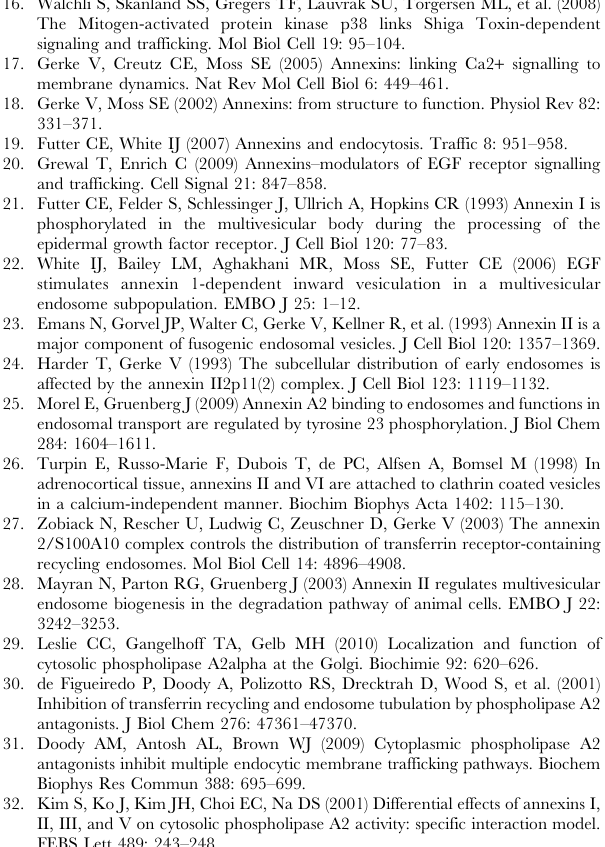
of total fluorescence for each marker, for one representative experiment (n= 3), where error bars indicate standard deviation. (TIF) Figure S5 Binding and endocytosis of Stx in Annexin A1 depleted cells. Stx binding and endocytosis following annexin A1 knockdown. HeLa cells transfected with siRNA as indicated for 72 h were incubated with , 0.5 nM biotin-Stx for the indicated timepoints. Endocytosed and total cell-associated toxin were quantified by electrochemiluminescence and compared to control siRNA treated cells. Data shown are the results from one representative experiment (n= 3) where error bars indicate standard deviation between triplicates from one sample. (TIF) Figure S6 Reduced ShigaB sulfation in response to cPLA2 inhibitor MAFP. HeLa cells were starved in the presence of radioactive sulfate for 2 h before addition of MAFP at the indicated concentrations. After 1 hour, ShigaB-sulf2 was added, and the incubation continued for an additional 45 minutes. Cells were lysed, ShigaB immunoprecipitated, separated by electrophoresis and analyzed by autoradiography. The total amount of sulfated protein was analyzed by TCA precipitation. The autoradiography (upper panel) shows results from one sulfation experiment performed in triplicate (duplicate for 50 m M MAFP), and the bar graph shows the quantification plotted as percentages of control values with error bars indicating standard deviation. The experiment was repeated once with similar results. (TIF)